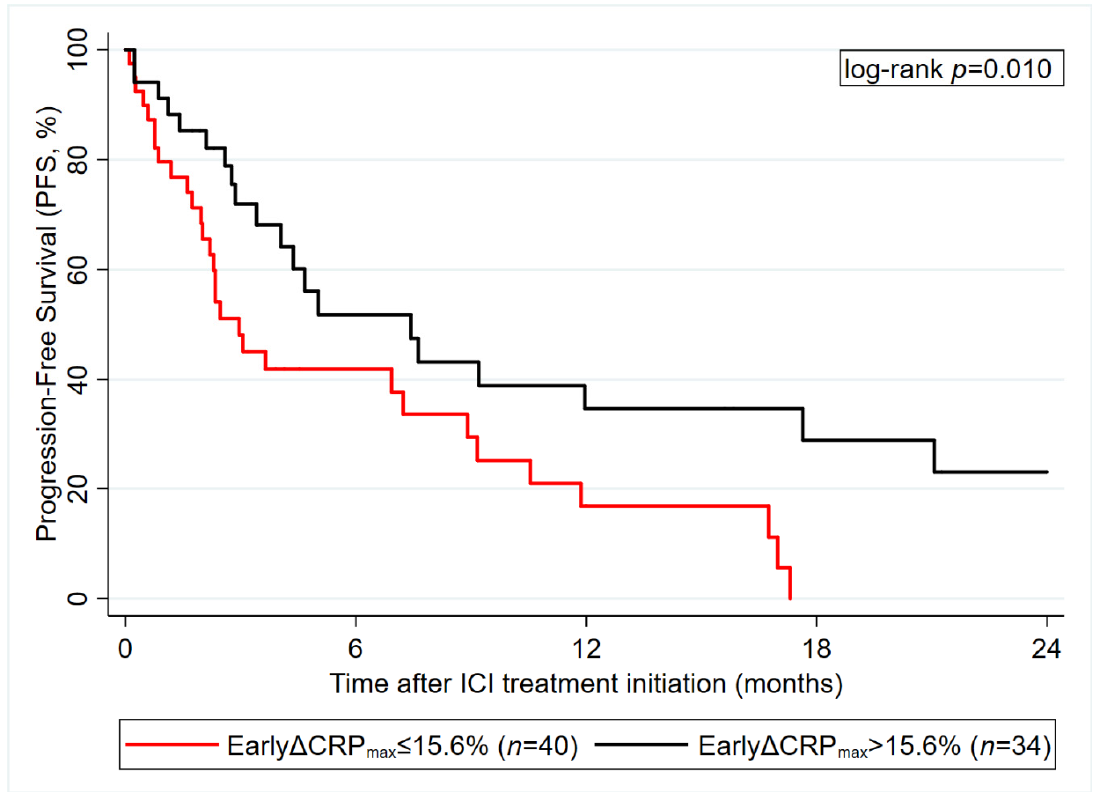
Figure 6. Exploratory, hypothesis-generating analysis of “early CRP decline” as a predictor of ICI therapy PFS outcome in the Graz cohort ( n = 74). Data are from patients with observed baseline CRP and available 8-week CRP data. Early CRP decline was defined as the maximum percent decline in CRP during the first 8 weeks after ICI treatment initiation, with patients with CRP increase set to 0. A cuto ff at 15.6% was derived using Youden’s Index. Abbreviations: PFS—progression-free